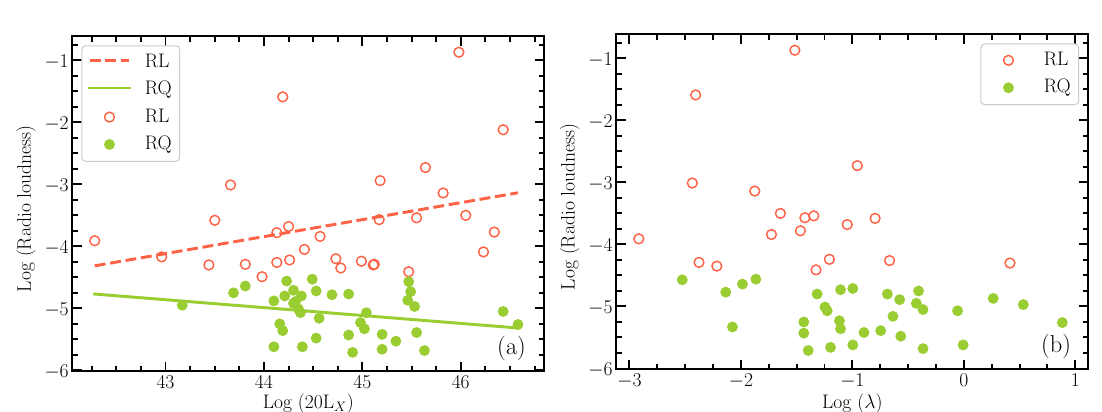
Figure 3. ( a ) Log (radio loudness) vs. Log (disk luminosity in ergs − 1 ), with the best linear fit y = ( 0.27 0.15 ) x 15.89, and y = ( 0.13 0.08 ) x + 0.61, for radio loud (red) and radio quiet sources ± − − ± (green). ( b ) Log (radio loudness) vs. Log (Eddington ratio) for radio loud (red) and radio quiet sources